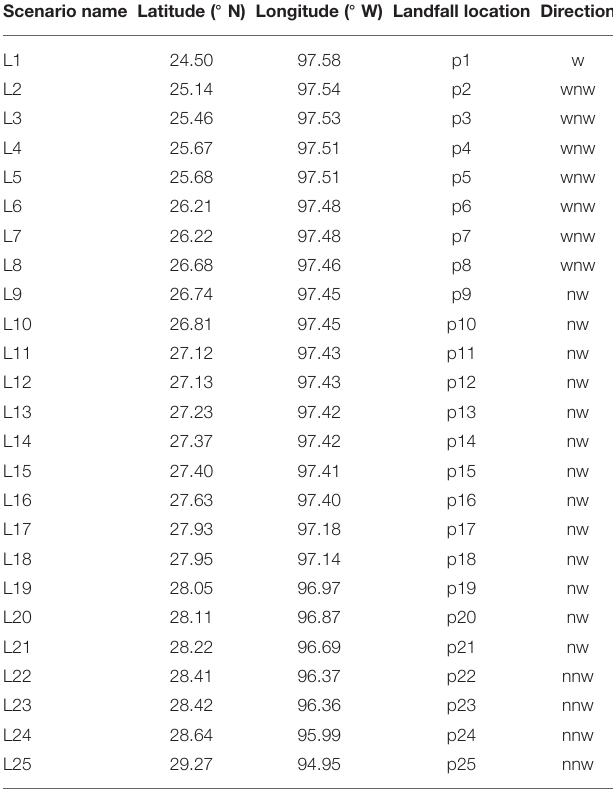
TABLE 1 | Landfall locations and matching storm surge directions.